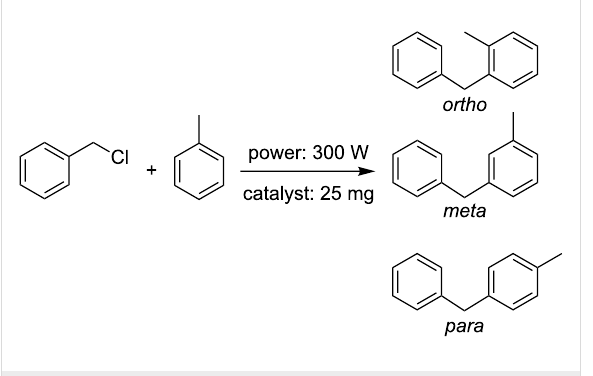
47%, which does not compensate the energy consumption by extending the reaction time from 10 to 30 min.